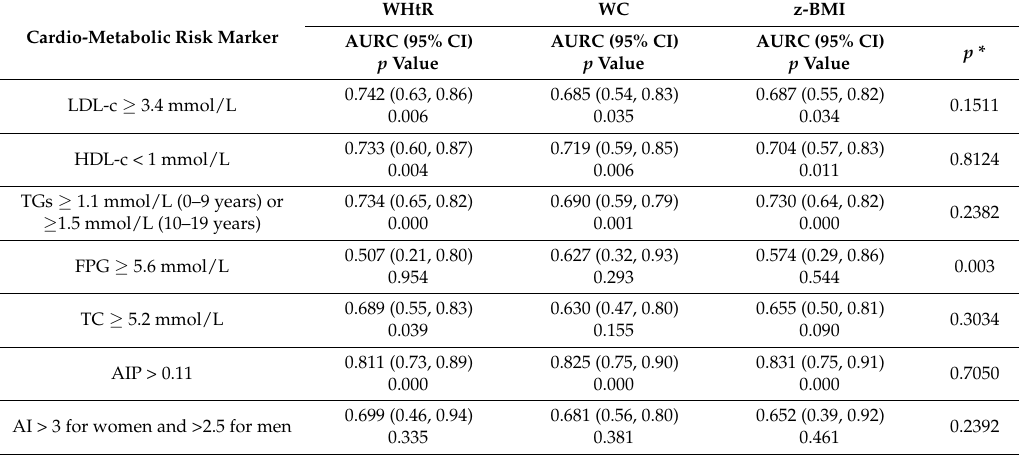
Table 3. Association of each adiposity indicator and cardio-metabolic risk factors using receiver operating characteristic